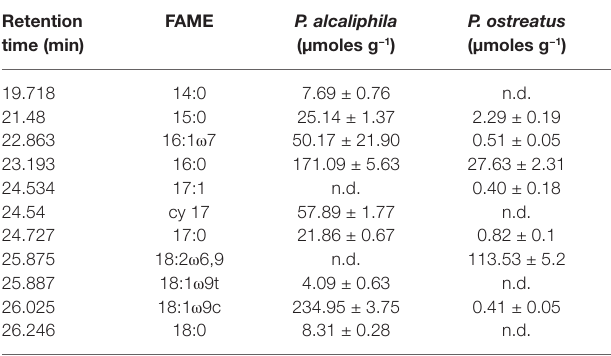
TABLE 2 | Ester-linked fatty acid methyl ester (El-FAME) analysis in mono- specific P. alcaliphila and P. ostreatus